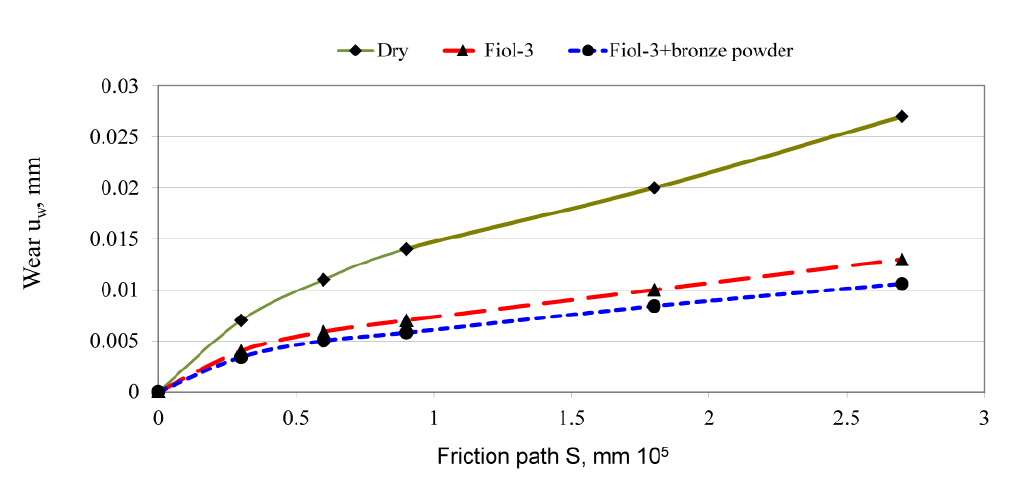
Fig. 4. Wear on the friction path with non-free contact of the cylinders ( Q = 100